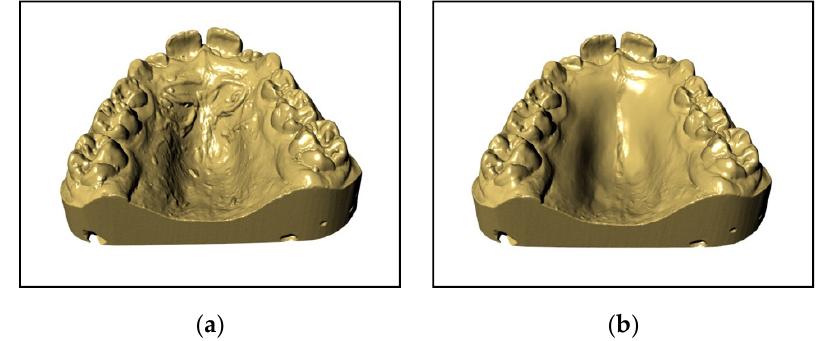
Figure 1. ( a ) Digital model of the upper arch. ( b ) Digital model of the upper arch after being smoothed.